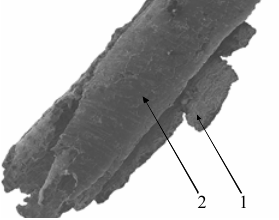
Fig 5. 1- inside wear fragment; 2- outside wear fragment ( · 52)